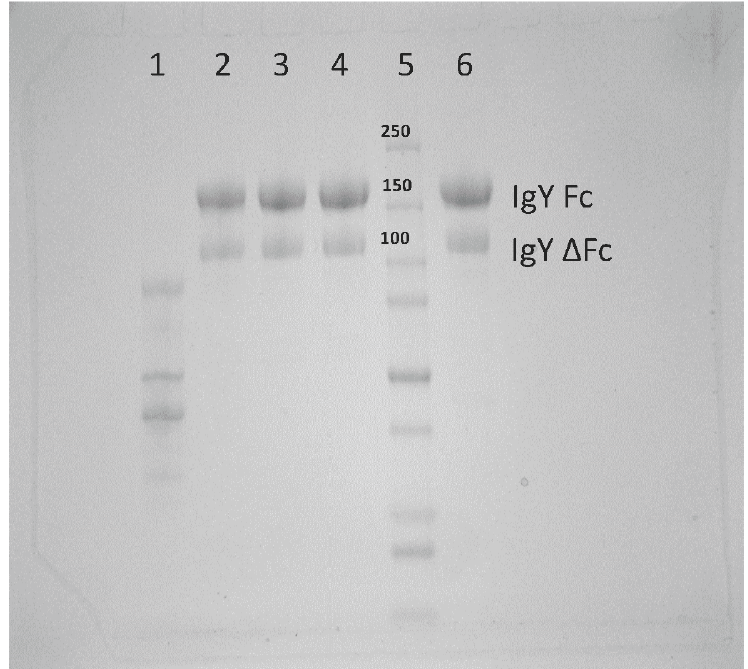
Figure 1. Anti-ZIKV (Zika virus) IgY purification: The purity of anti-ZIKV IgY after the second polyethylene glycol (PEG) precipitation. Lane 1, supernatant from the PEG precipitation; lane 2, resuspended PEG pellet; Lanes 3 and 4, molecular weight concentration and diafiltration; Lane 5, molecular weight marker; and Lane 6, control naïve IgY that was previously purified via mercapto-ethyl pyridine HyperCel Hydrophobic Charged Induced Chromatograph for